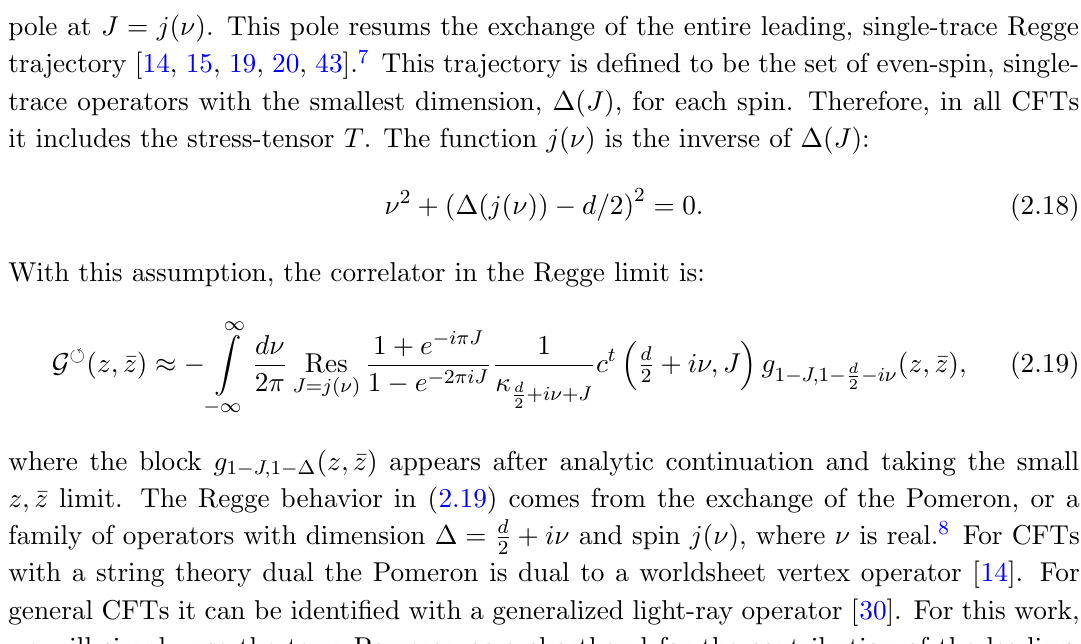
Figure 2 . The red contour (cid:0) comes from the original, partial wave decomposition. We deform it to the blue contour (cid:0) 0 and in the process pick up a pole, j ( (cid:23) ), which gives the leading Regge growth. We have suppressed other possible non-analyticities, such as branch